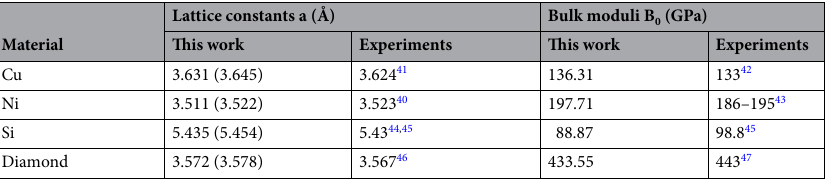
Table 1. The calculated lattice constants and bulk moduli B 0 , in comparison with experiments. And the calculated lattice constants at room temperature were also listed in parentheses.